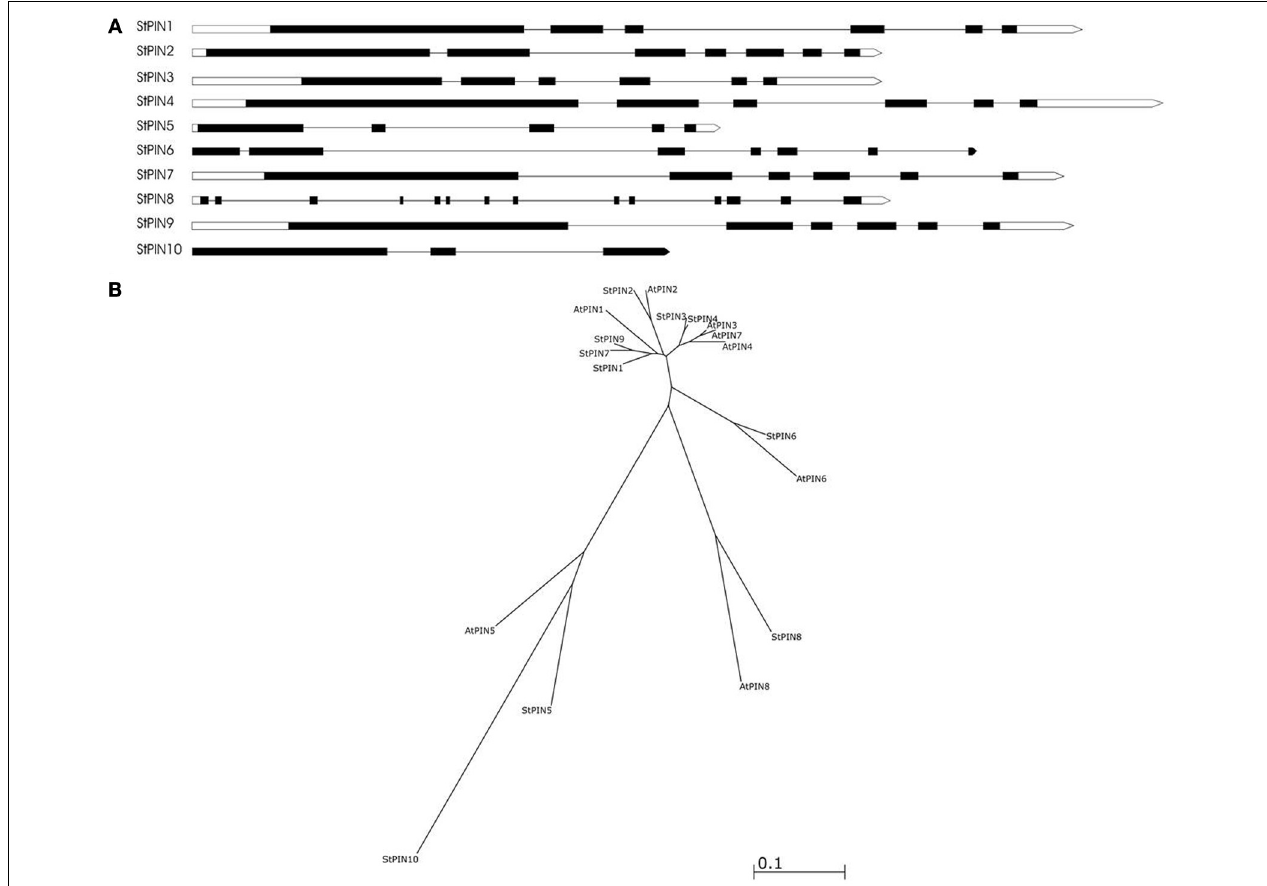
FIGURE 1 | The predicted gene structure and phylogenetic relationships of the StPIN family of genes. (A) The direction of transcription is from left to right. Black boxes represent the exons, white boxes represent the 5’ and 3’